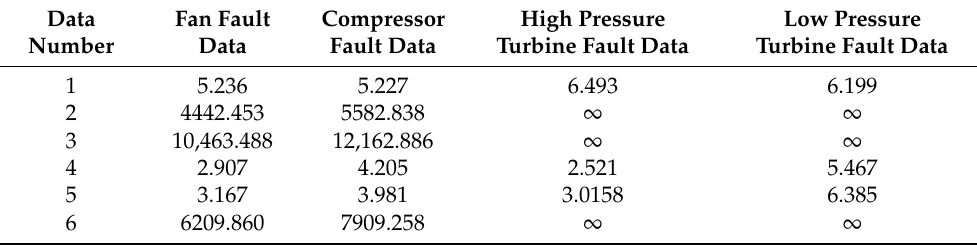
Table 7. Distances of IMF